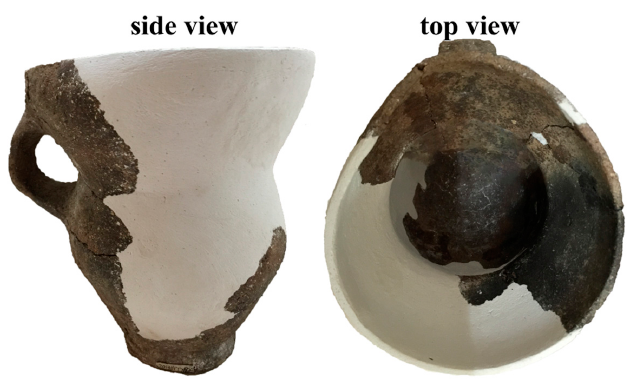
Figure 3. Unearthed po tt ery from the site the Yubeidi site.